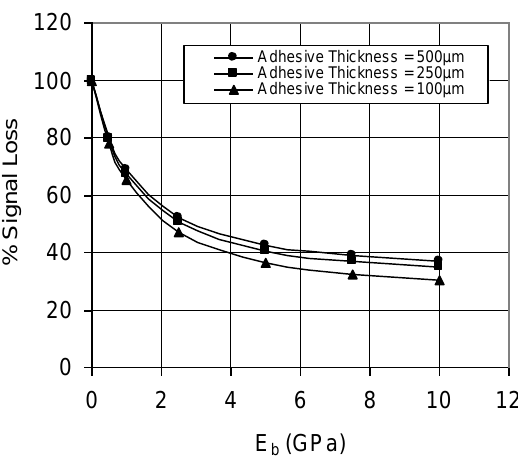
Figure 7. Effect of adhesive material properties (modulus of elasticity, E output signal, V = 5 V. i